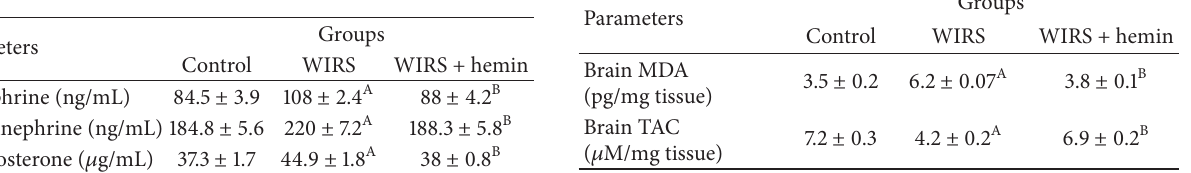
Table 1: Effect of 6-hour water immersion restraint stress (WIRS) with or without hemin on serum catecholamines (epinephrine and norepinephrine) and corticosterone in male albino rats.